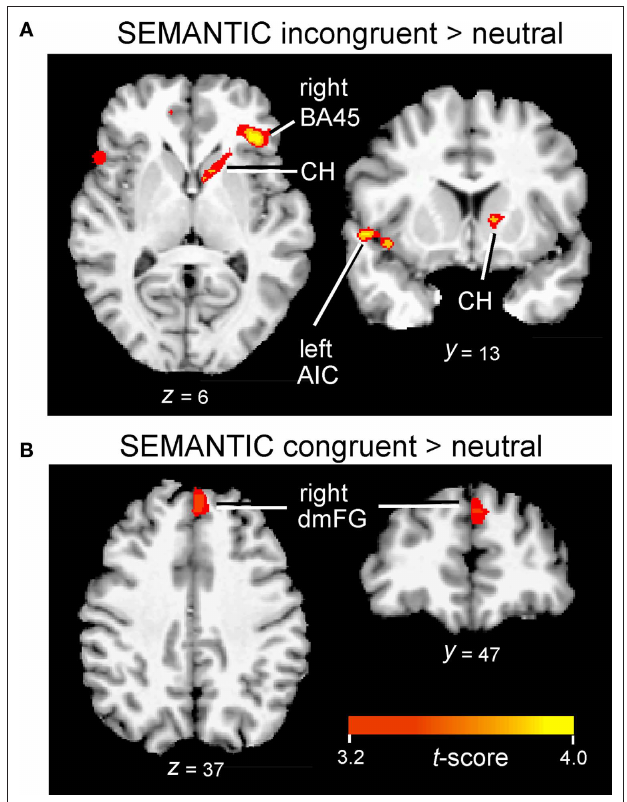
FIguRe 6 | Inferior frontal, insular, and subcortical activation associated with interference (A) and facilitation (B) in the SEMANTIC task. Cluster-wise activation threshold = p < 0.01, corrected. AIC, anterior insular cortex; BA45, pars triangularis; CH, caudate head; dmFG, dorsomedial frontal